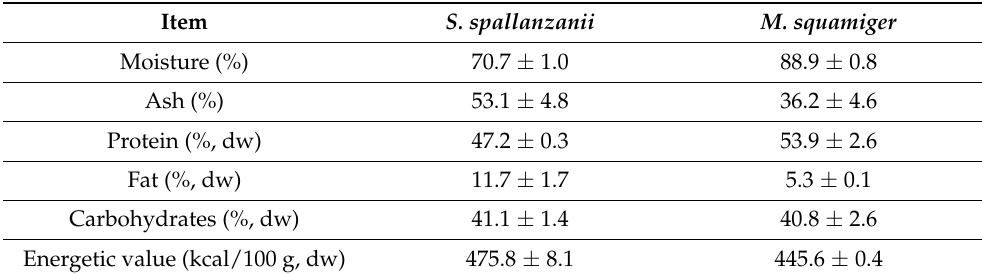
Table 1. Proximate composition and energetic value of the biomass of Sabella spallanzanii and Microcosmus squamiger .